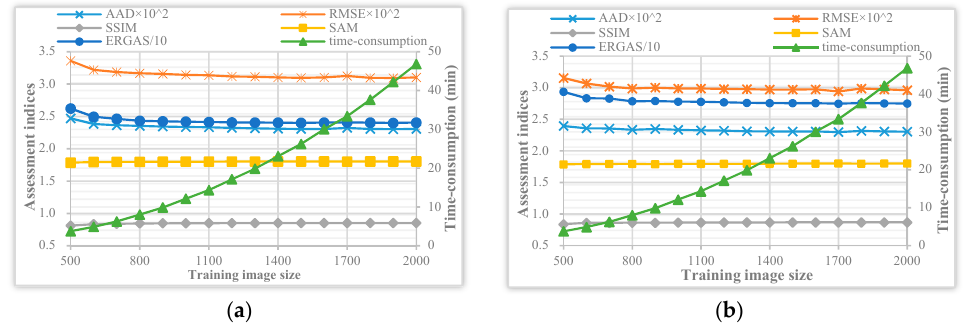
Figure 7. Graphical assessment indices of the proposed bi-directional fusion with spatially extended training samples from the urban dataset, ( a ) and ( b ) are respectively for modeling the reflectance on 10 July and 12 September 2017. Remote Sens. 2018 , 10 , x FOR PEER REVIEW